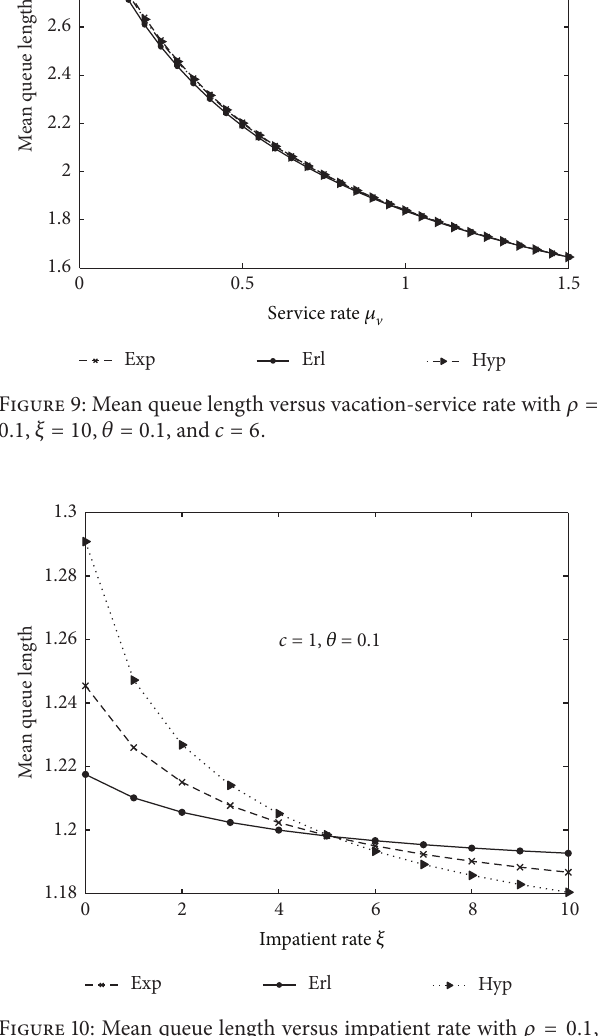
Figure 12: Mean queue length versus impatient rate with 𝜌 = 0.1 , = 0.2 , and 𝑐 = 6 𝜇 V